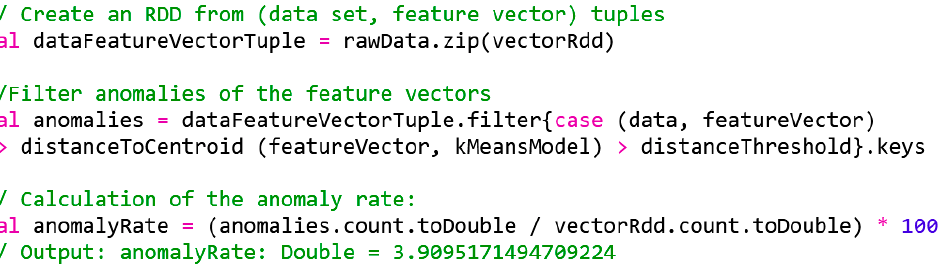
Figure 11. Detection of anomalies in the vector RDD.